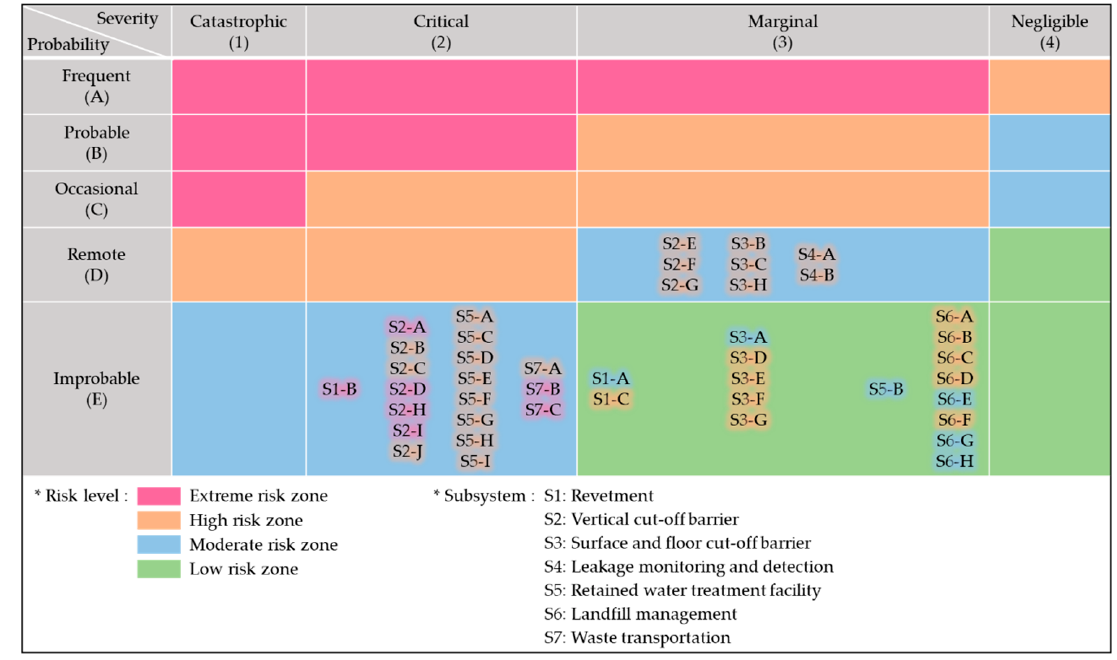
Figure 7. Risk assessment matrix of the final subsystem hazard analysis (SSHA) of the offshore waste disposal facility. Blurred background colors indicate the results of the initial SSHA.